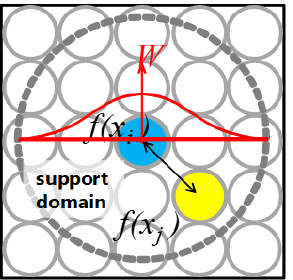
Figure 2. Influence domain of SPH particles (kernel